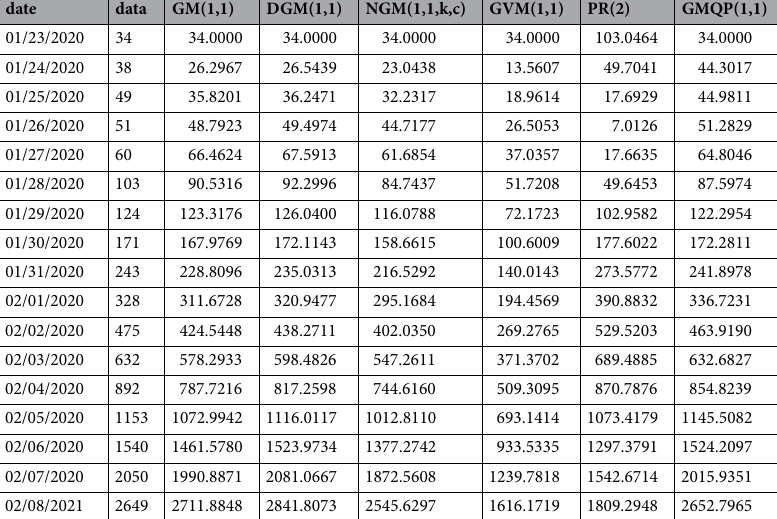
Table 15. The computational results of the recovered cases of COVID-19 of China.